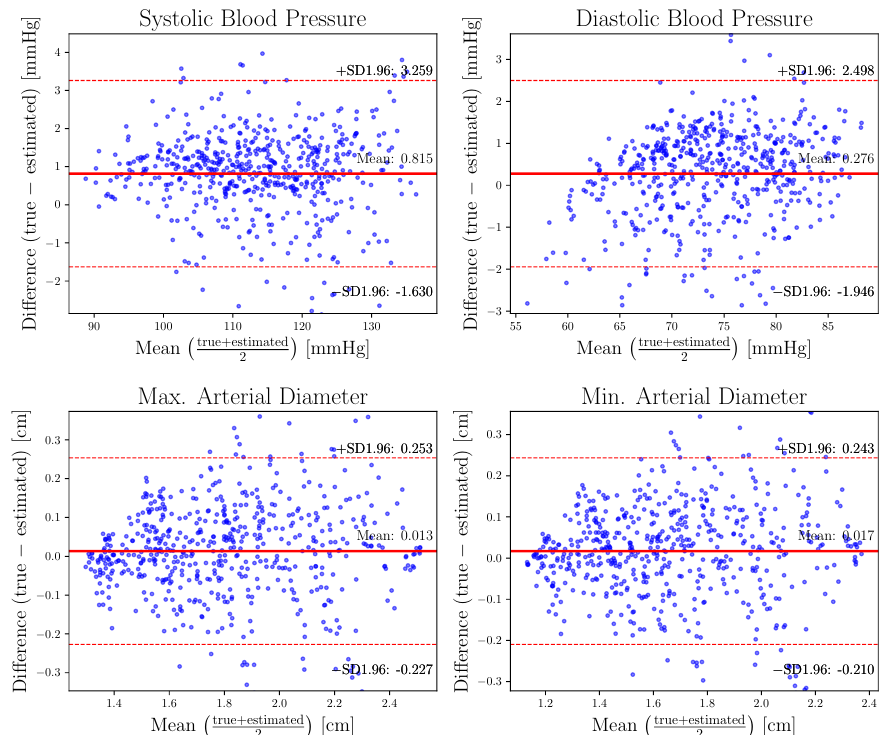
Figure 7. Bland–Altman plots showing the difference between the maximum and minimum values of pressure ( top ) and diameter ( bottom ) for true and estimated signals; the plots were obtained for the best LSGAN